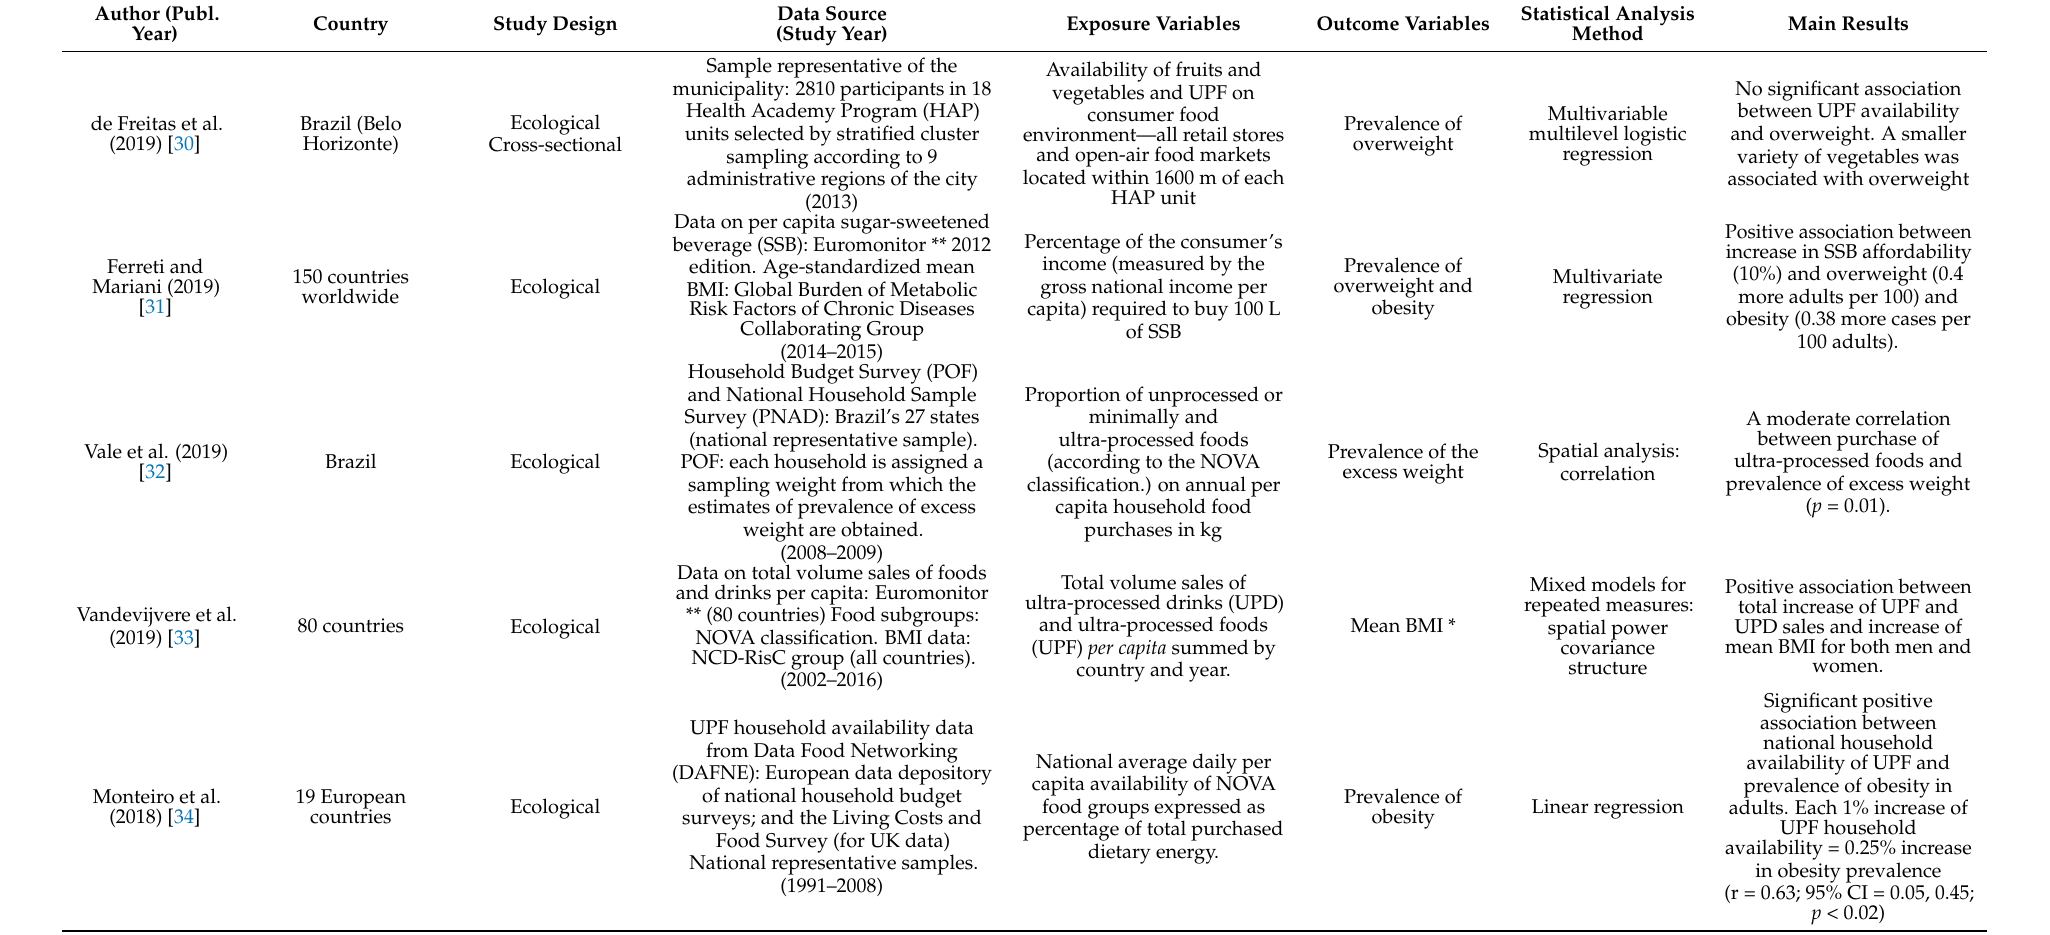
Table 1. Summary of the eleven studies included in the systematic review of UPF availability associated with health outcomes (February